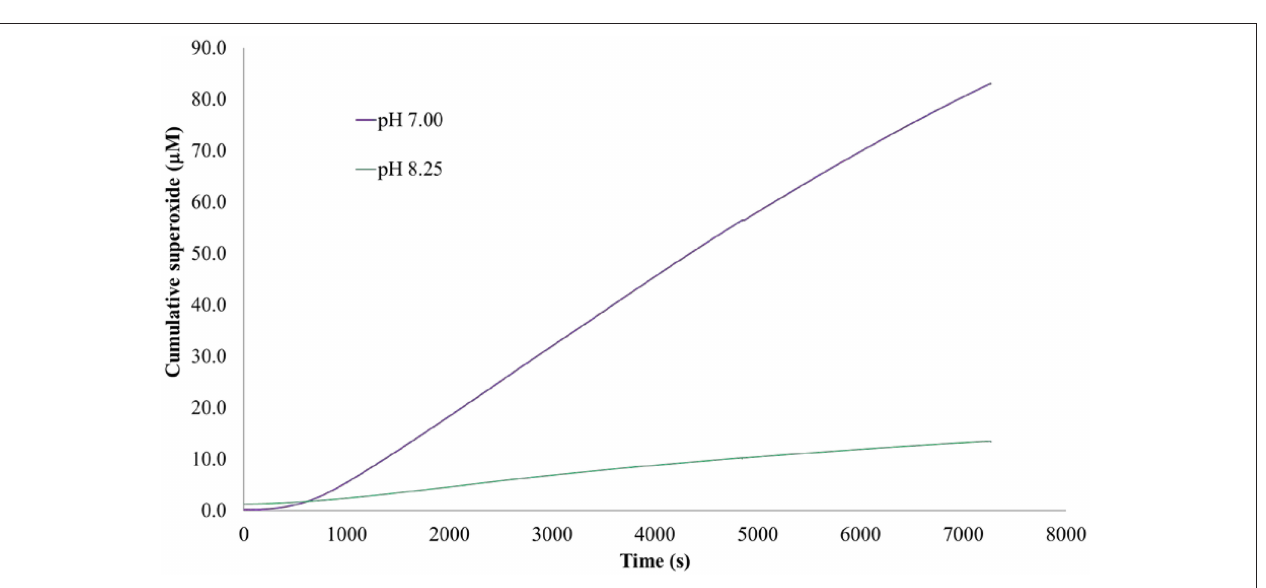
FIGURE 6 | Estimated cumulative superoxide production. The measured, instantaneous concentration of superoxide was used as input with Equation (11) to solve for the total number of moles of superoxide generated over the course of the experiment at 7.00 and pH 8.25. The instantaneous concentration of superoxide was lower at pH 7.00 than 8.25 but the cumulative production was higher, correlating with an increased loss of superoxide from dismutation at the lower pH and consistent with Equation